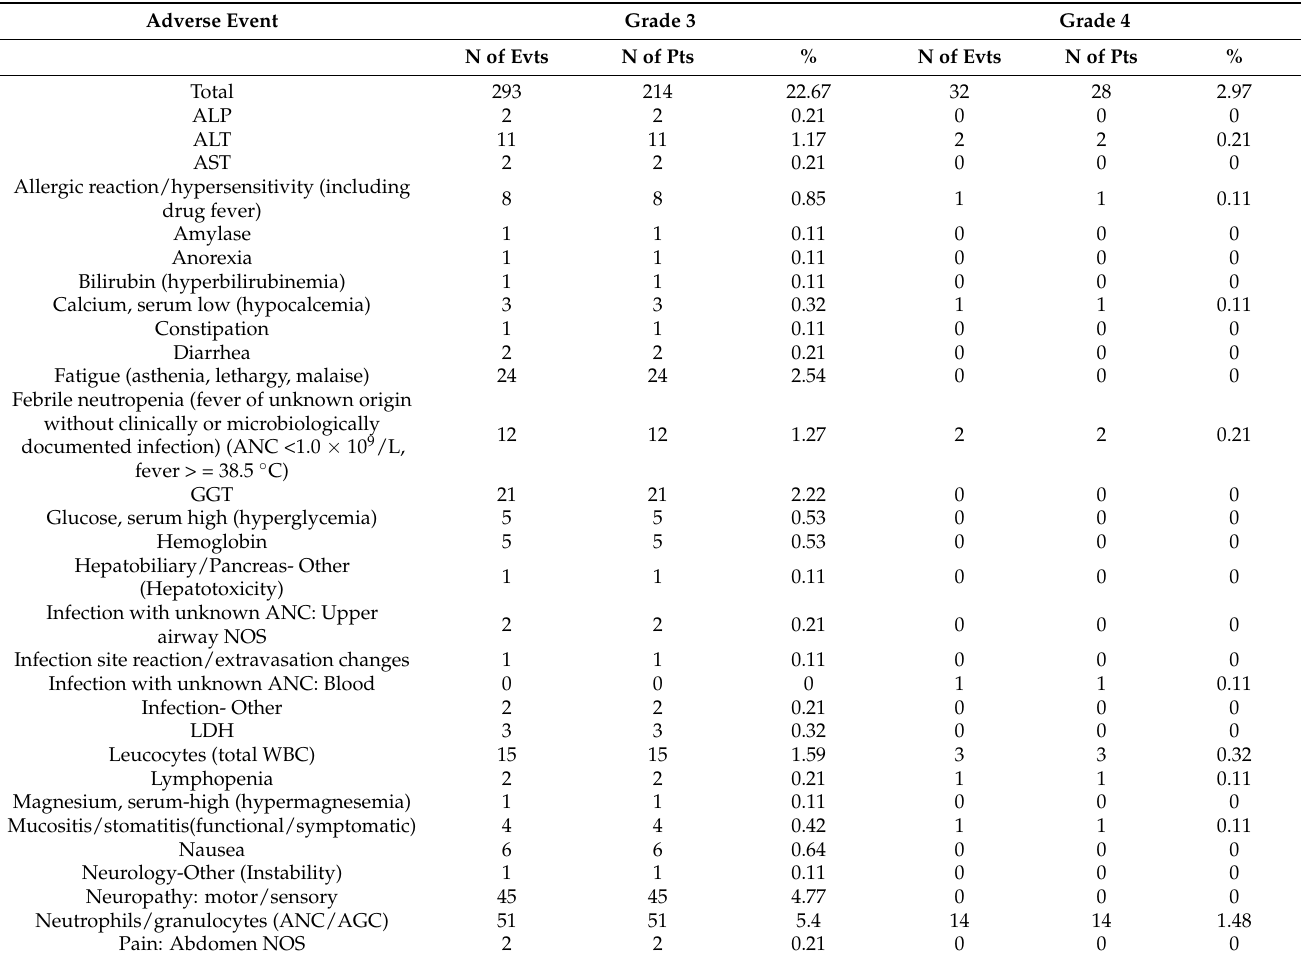
Table 3. Incidence of grade 3 and 4 adverse events recorded throughout the study treatment among the 944 patients with available